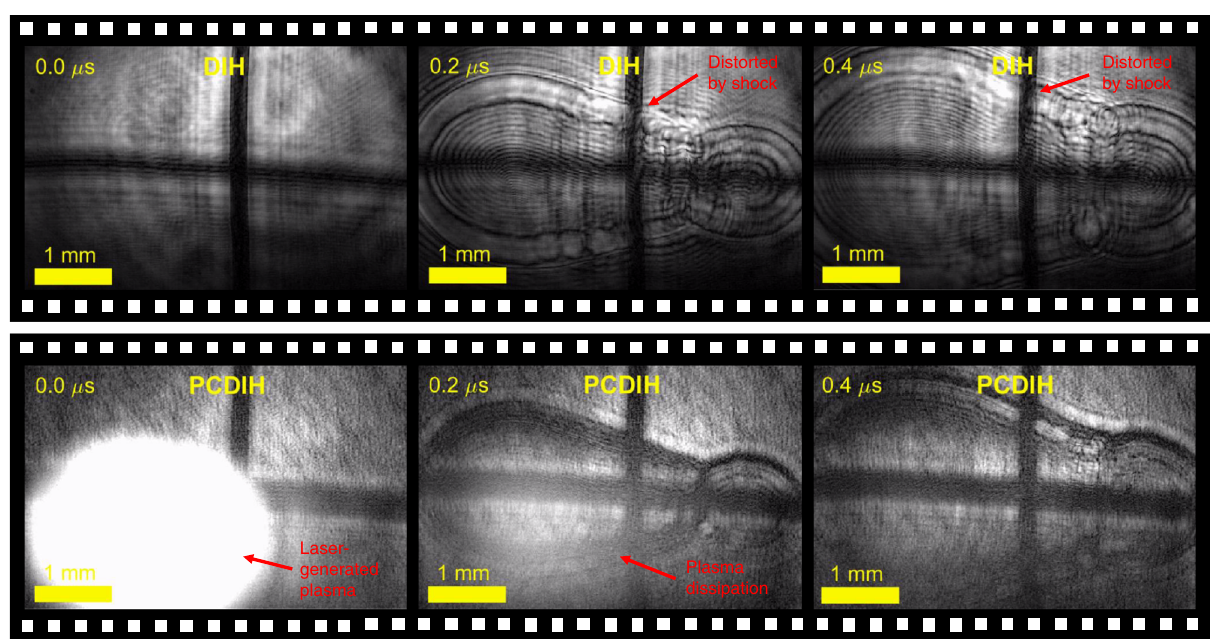
Fig. 5 Laser-spark plasma-generated shock-wave videos collected at 5 MHz. The dynamics of shock-wave expansion over time are illustrated from data collected at ultra-high imaging rates. For this particular experiment, the plasma emission overwhelms the fi rst frame of the PCDIH signal. Holograms captured at 500 kHz and 5 MHz are illustrated in Supplementary Movie 2.